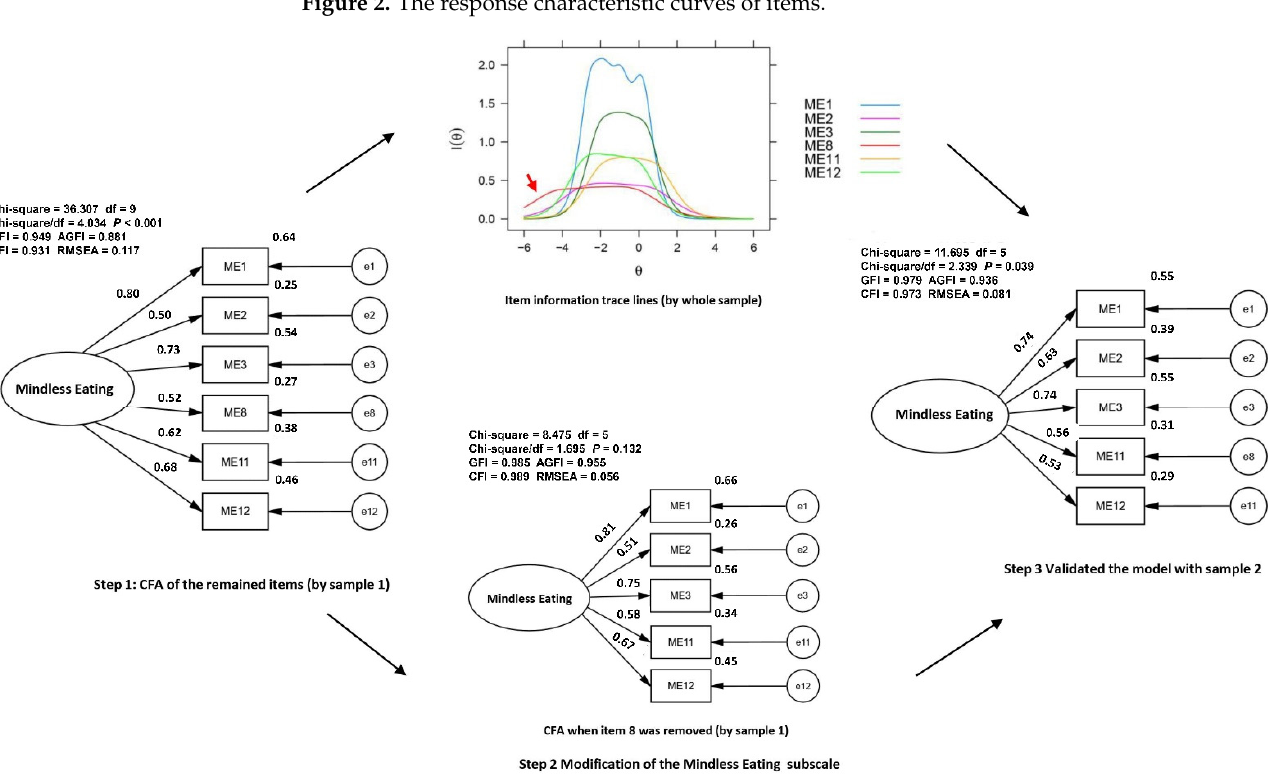
Figure 3. The modification and validation of the Mindless Eating Subscale assisted by item infor- mation trace